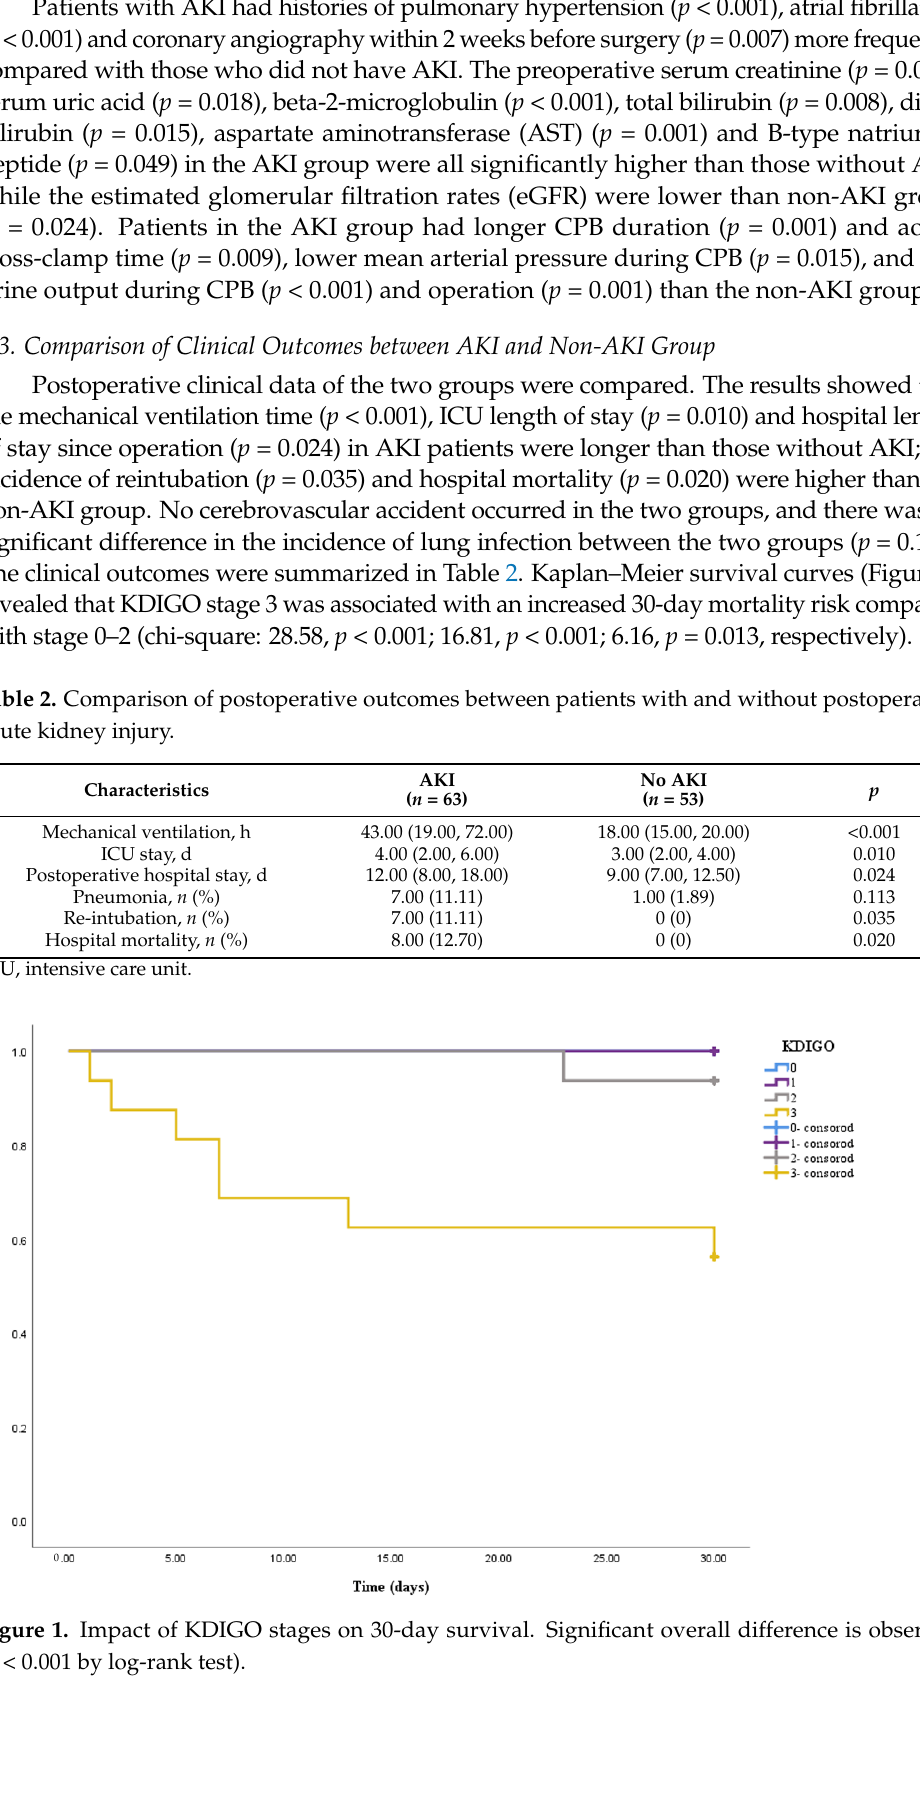
gender, high preoperative serum creatinine, low estimated glomerular filtration rate, ele- vated serum uric acid, AST, total bilirubin and direct bilirubin, preoperative pulmonary